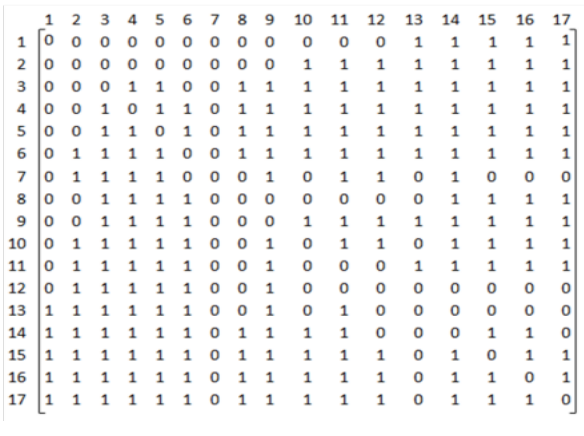
Figure 2. (a) to (f) represents the reduction gear-box assembly in ACM, ASM and